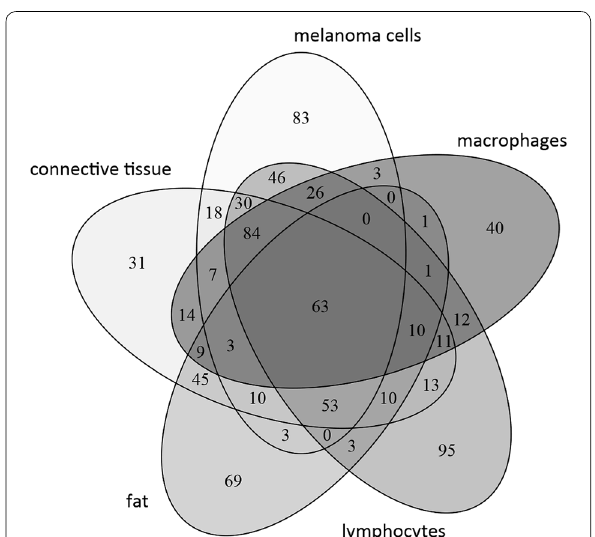
Fig. 6 Venn diagram showing the distribution of the detected endogenous signals present in the different regions of the MALDI images from melanoma tissue samples isolated after surgery